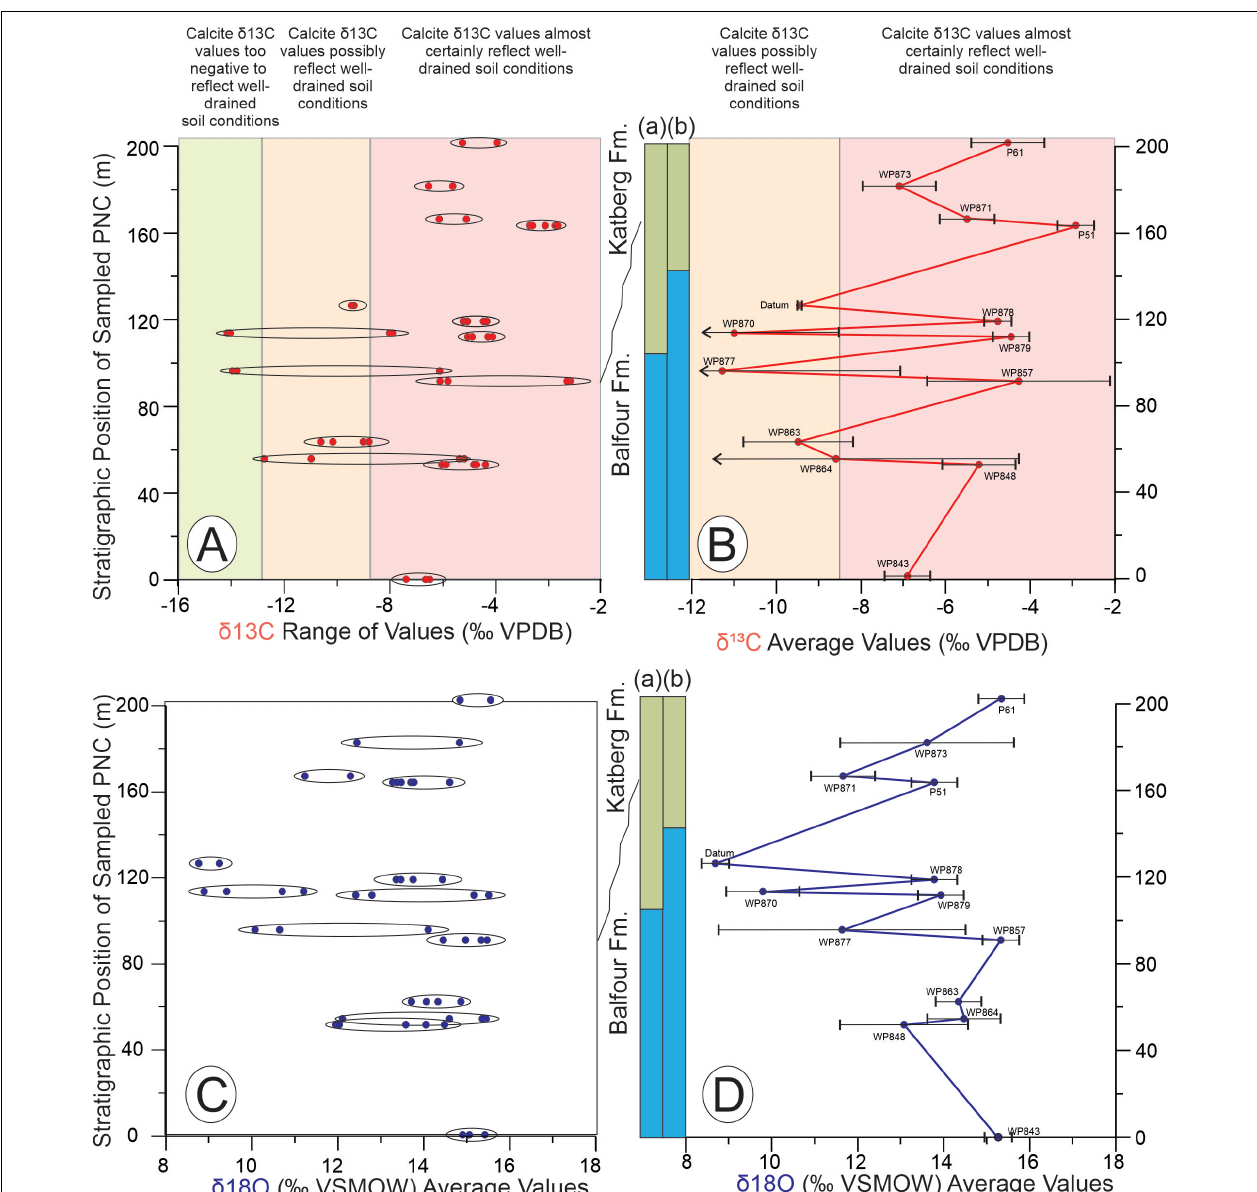
FIGURE 7 | Plots of δ 13 C VPDB and δ 18 O VSMOW values in stratigraphic order through the upper Daptocephalus (blue bar) and lower Lystrosaurus (light green bar) Assemblage Zones. Placement of the biozone boundary follows Smith and Botha-Brink (2014) on the left; on the right, placement follows Gastaldo et al. (2017, 2018). (A) Plot showing variation in δ 13 C values for each sampled horizon against interpreted paleosol conditions under which calcite cement precipitated. (B) Plot of mean δ 13 C VPDB value for each sampled horizon against interpreted paleosol conditions under which calcite cement precipitated. (C) Plot showing variation in δ 18 O VSMOW values for each sampled horizon. (D) Plot of mean VSMOW value for each sampled horizon against sampled position in the Daptocephalus and Lystrosaurus Assemblage Zones. Standard deviation is provided around the mean values. Note that bimodal data exhibit a larger standard deviation.